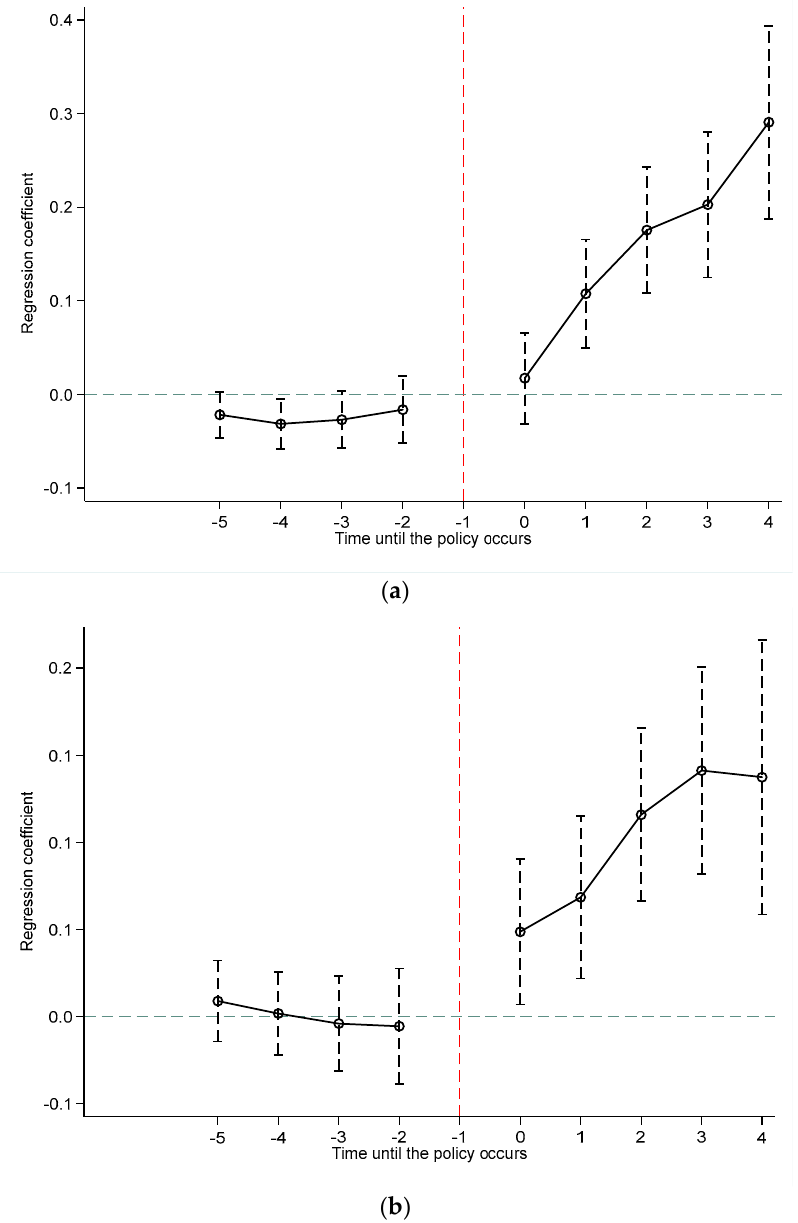
Figure 2. Parallel trends test in pre-treatment periods. ( a ) The grain sown area, ( b ) The Total Grain Production. Note: The graph uses the period before the policy occurred as the base period, and the coefficients for all other periods are relative to that period. The hollow points are the point estimates of the coefficients for each period, and the short vertical lines are the confidence intervals at the 95% significance